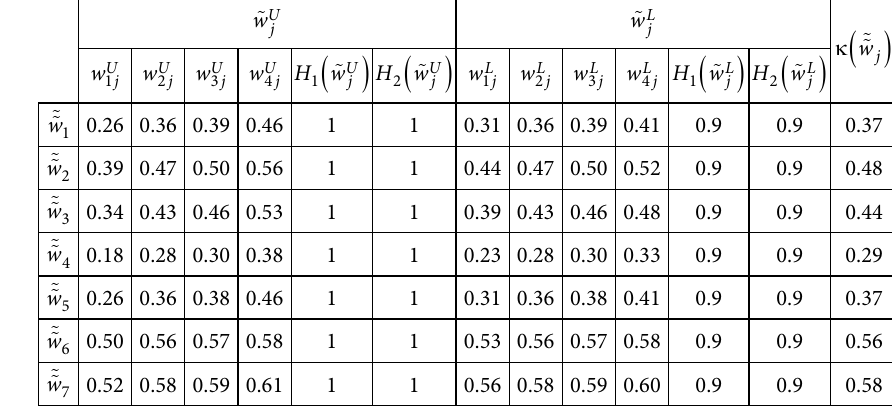
Table 4. The aggregated weights of